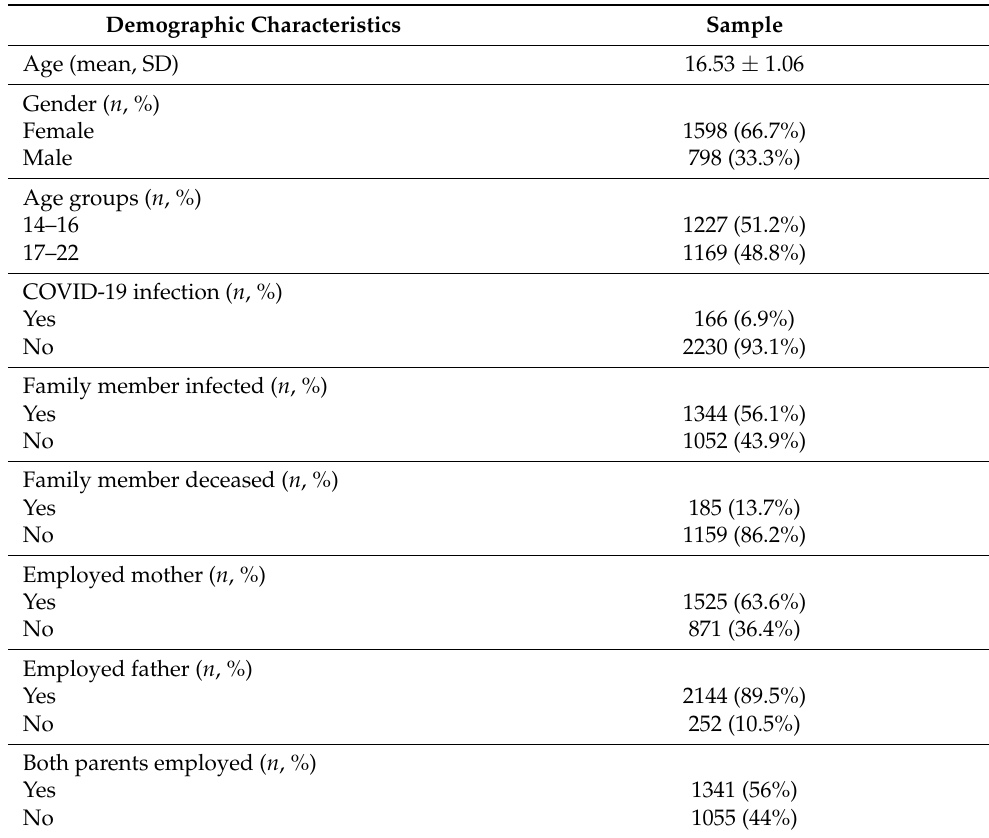
Table 1. Participants’ demographic